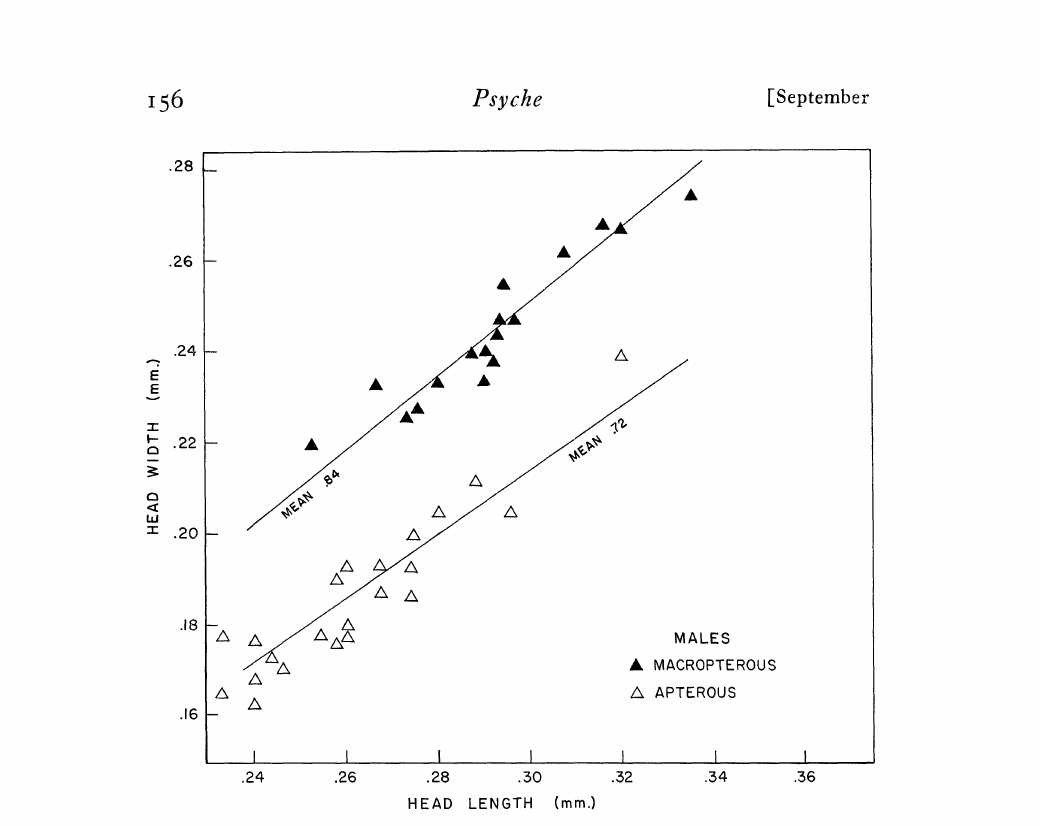
Fig. 1. Head width plotted against head length in the two forms of Cephal- onomia perpusilla males. of propodeum; ocelli present but small and weakly convex. Coloration as in micropterous female, head and thoracic dorsum polished and only very obscurely alutaceous. Sides of head subparallel except weakly converging anteriorly and posteriorly, .eyes rather flat, not notably protruding from surface of head; eyes very small, weakly hairy, removed from base of mandible, by .7 X their own height, removed from vertex crest by nearly twice their own height; minimum width of front 1. 7 X eye height. Scutellum weakly separated from mesoscu- turn, with a very thin basal transverse